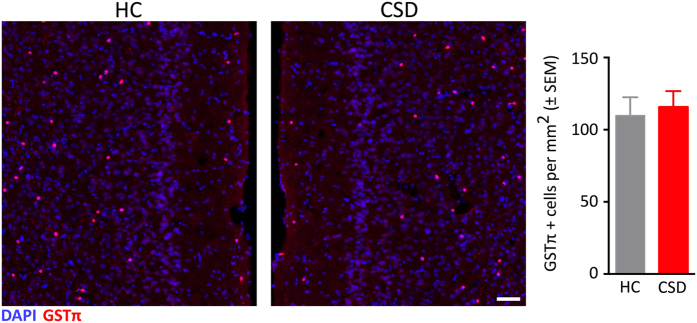
Chronic stress did not alter the number of mature oligodendrocytes (GSTπ-immunolabeled cells) in the mPFC.Confocal microscope images show similar densities of GSTπ positive cells in the mPFC of HC and CSD mice. No significant differences in GSTπ cell density were observed (graph). Results are expressed as mean ± SEM (n = 6 per group). Scale bar = 50 μm. Unpaired two-tail t-test (p > 0.05).